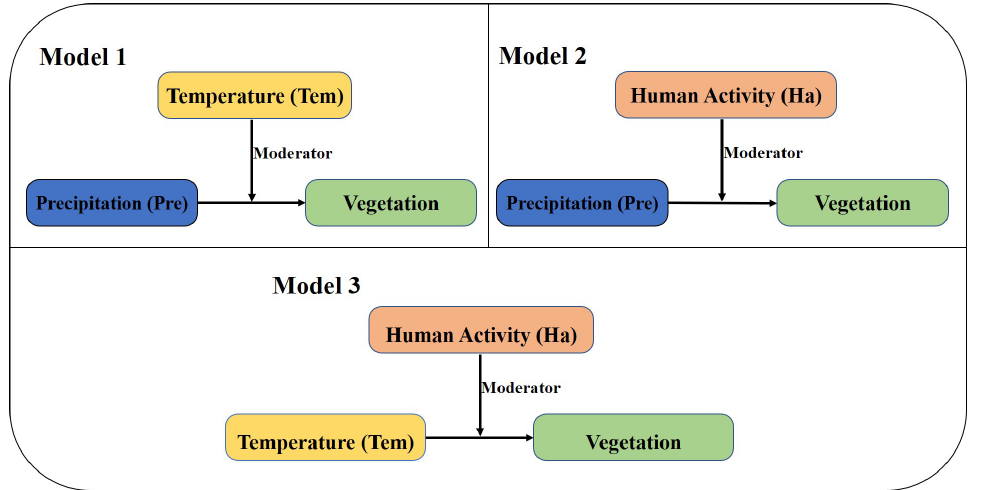
Figure 13. Mechanisms of dominant factors on vegetation growth in Northeast China. The dominant factors including precipitation (Pre), temperature (Tem) and human activity